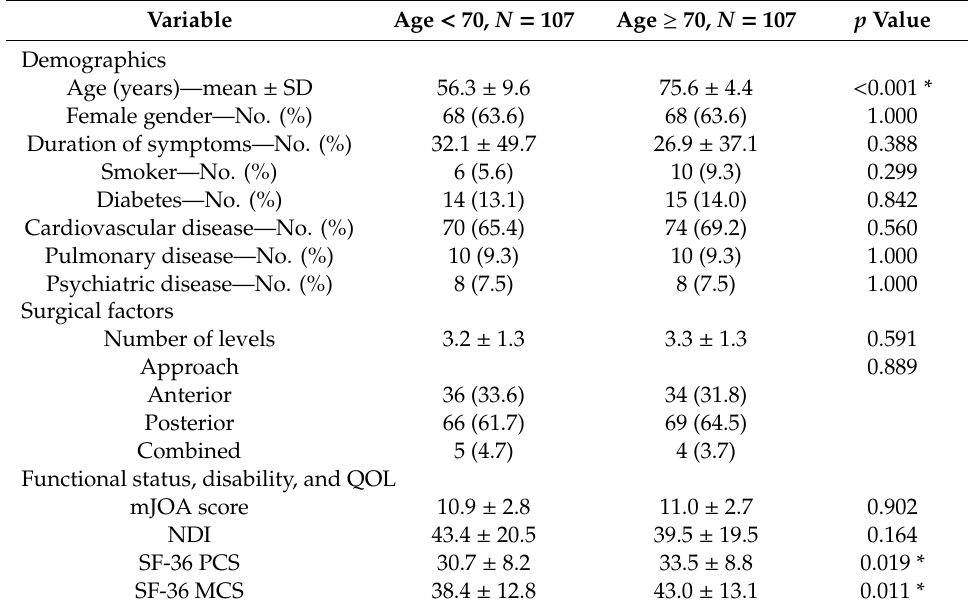
Table 1. Baseline demographics of the elderly cohort and younger cohort after propensity matching for gender, duration of symptoms, smoking status, co-morbidities, surgical factors, and baseline functional